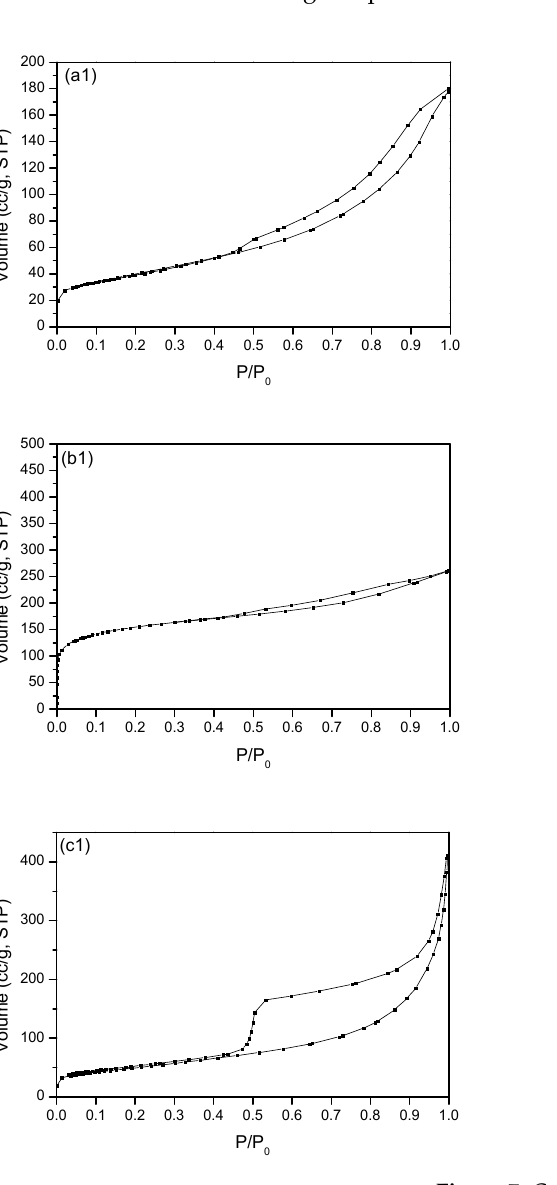
Table 1. Inductively coupled plasma (ICP) results of as-prepared catalysts. Notiation